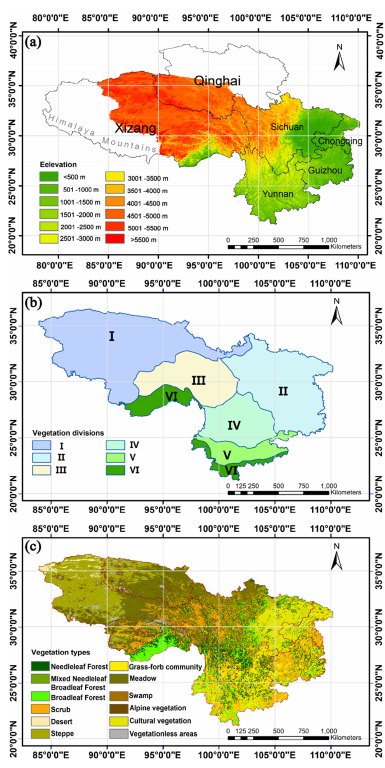
Figure 1. Overview of ( a ) topography, ( b ) vegetation divisions and ( c ) vegetation types in part of southwestern China. The clear space in panel ( a ) are areas within the respective provincial territory not included in this study. Vegetation divisions: I, alpine vegetation region; II–V, respectively, represent the northwest region, west central region and northwest region of subtropical evergreen broad-leaved forest; and VI, tropical monsoon forest.